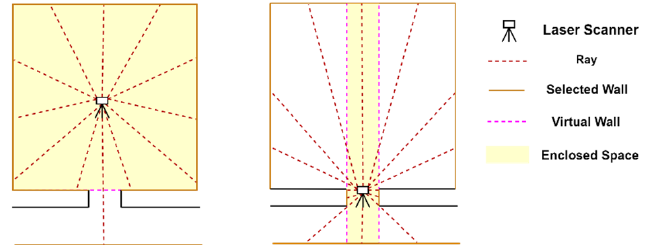
Figure 7. Construct virtual enclosures in different areas.